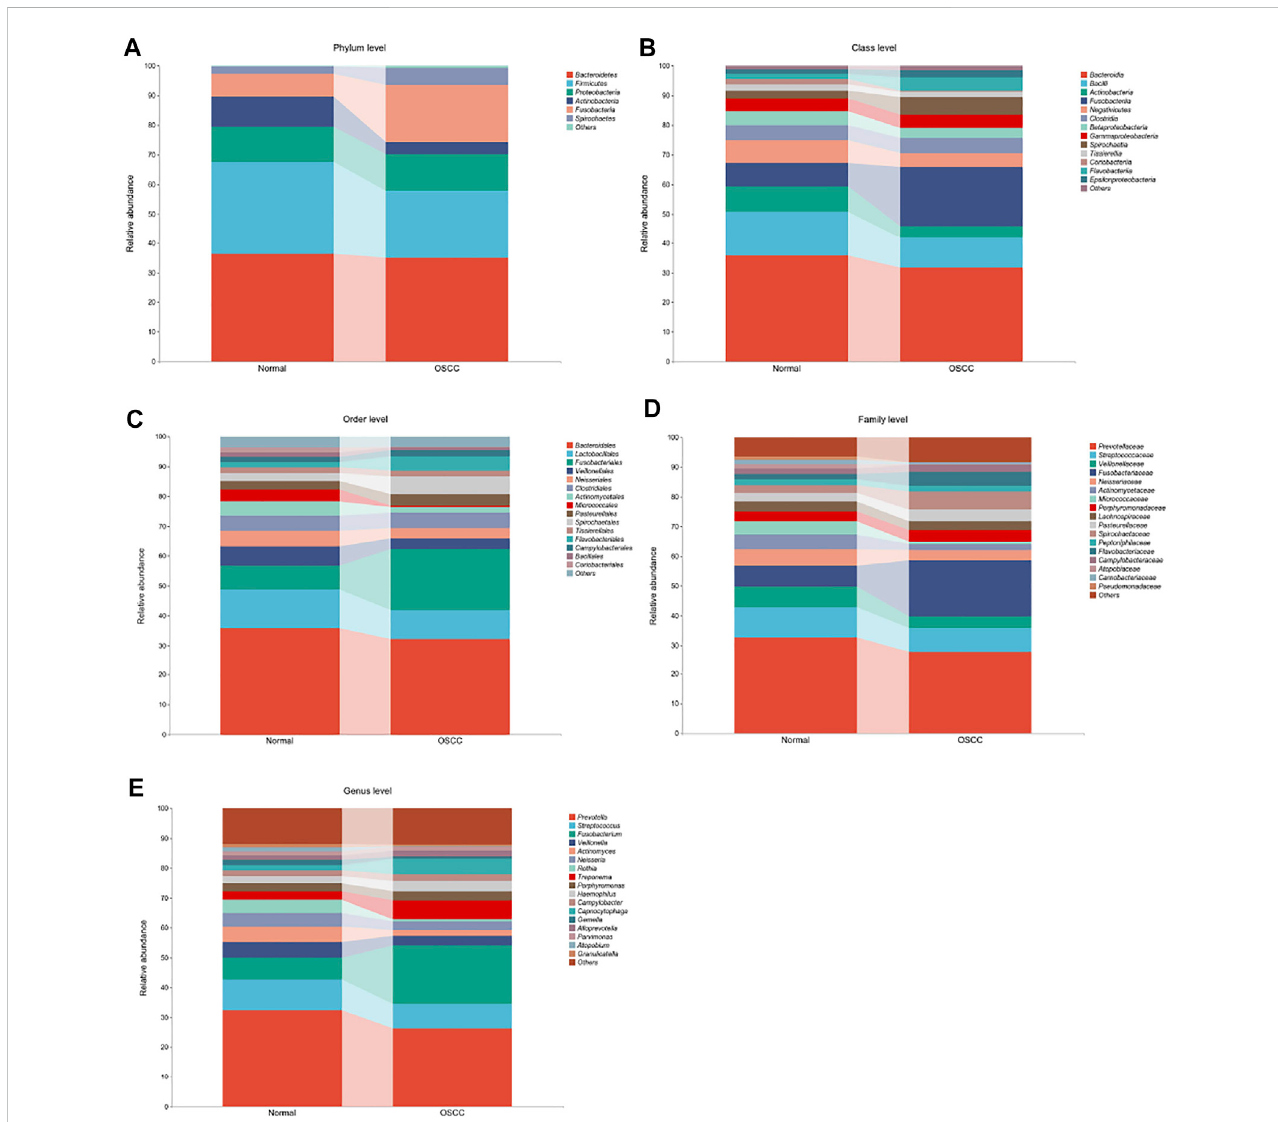
FIGURE 2 Oral microbiota pro fi le analyses of OSCC tumor and normal tissue based on fi ve different microbial levels. (A – E) . Oral microbial composition with > 1% difference in relative abundances between OSCC and normal controls (statistically signi fi cant between group comparisons, p < .05).